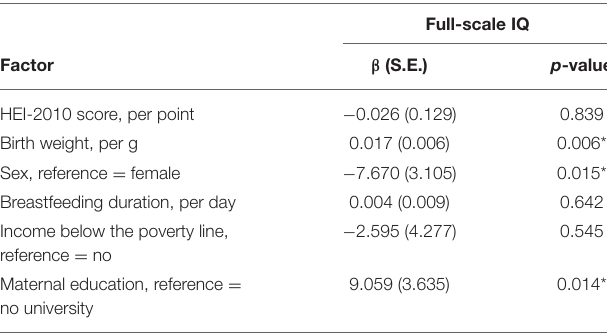
TABLE 3 | Associations between diet quality, sociodemographic variables and IQ in children born VLBW ( n =